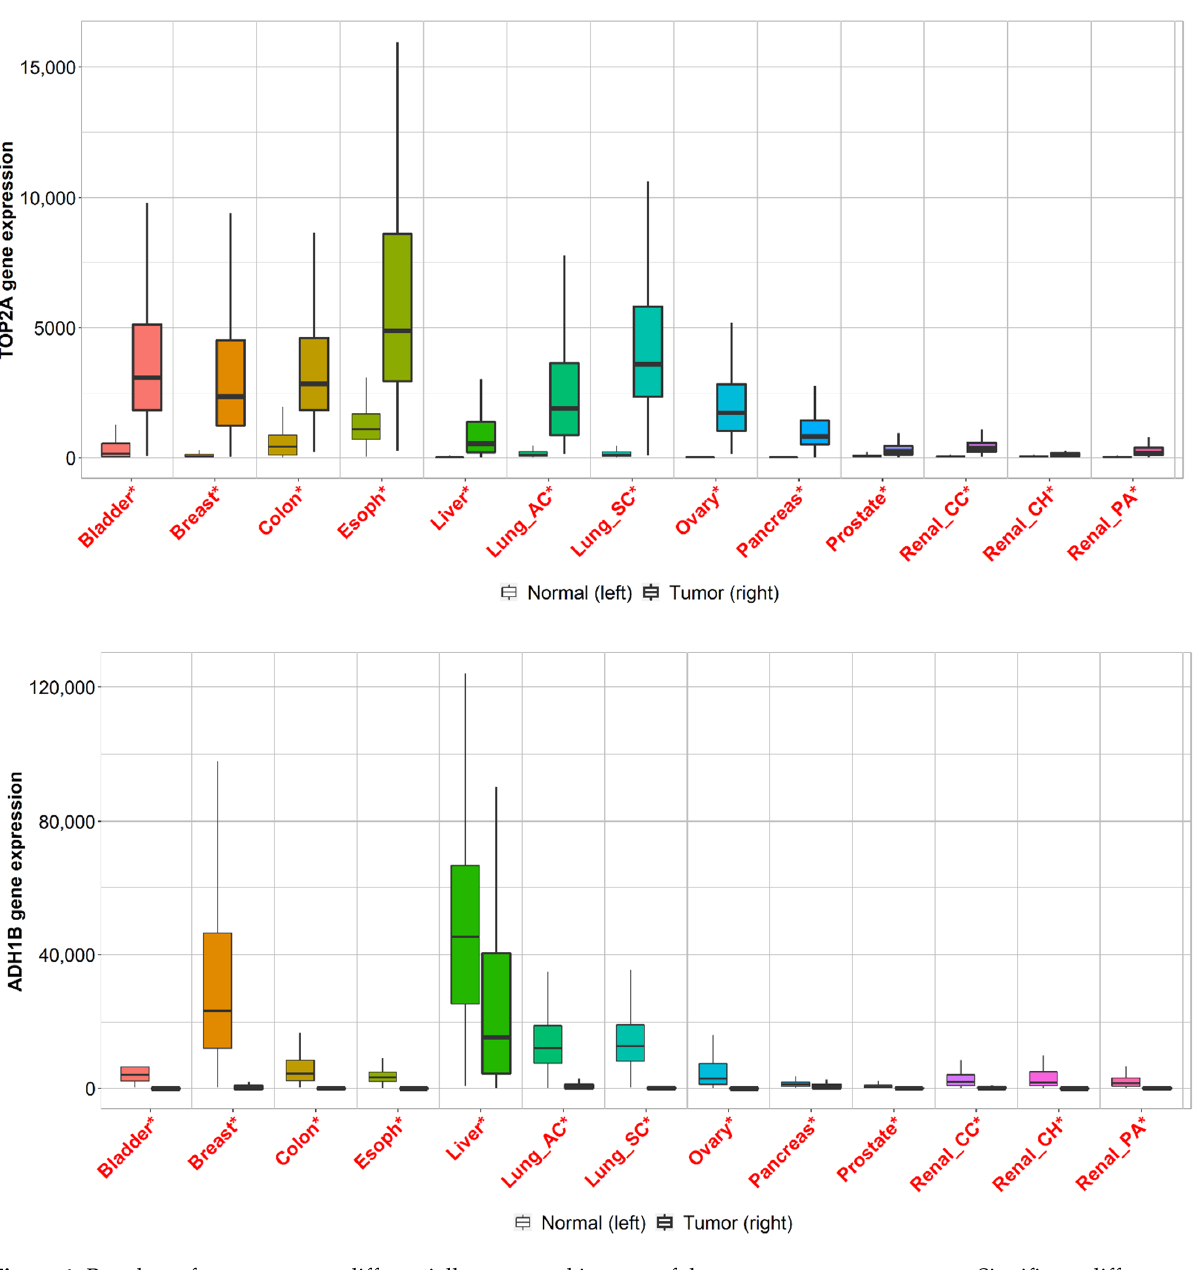
Figure 1. Boxplots of top two genes differentially expressed in most of the ten common tumor types. Significant differences